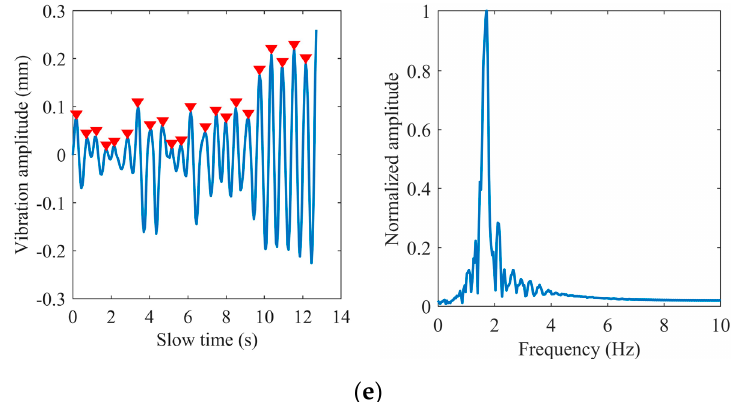
Figure 12. Subject #3: ( a ) extracted phase; ( b ) phase difference; ( c ) the impulse noise removal; ( d ) breathing waveform; ( e ) heart waveform.